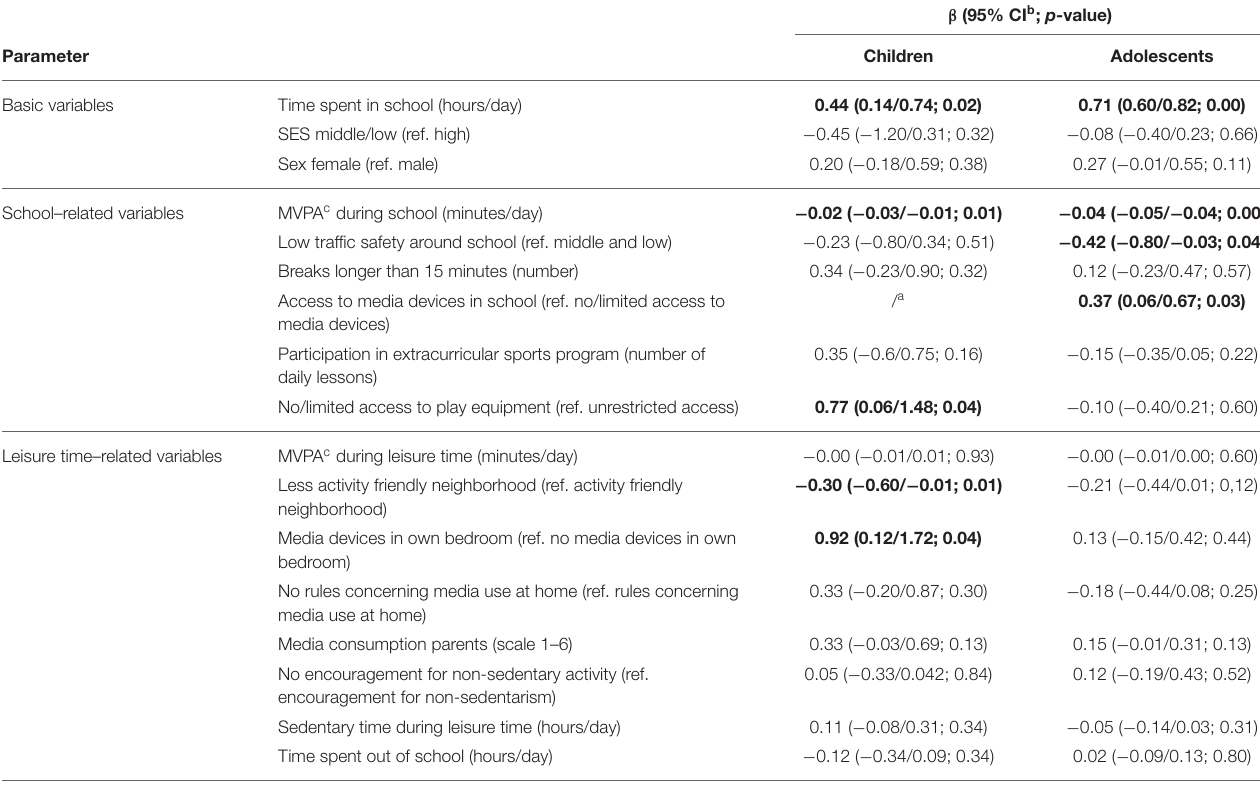
TABLE 3 | Results of multilevel models on the association between school and leisure time related factors and sedentary behavior during school (measured in